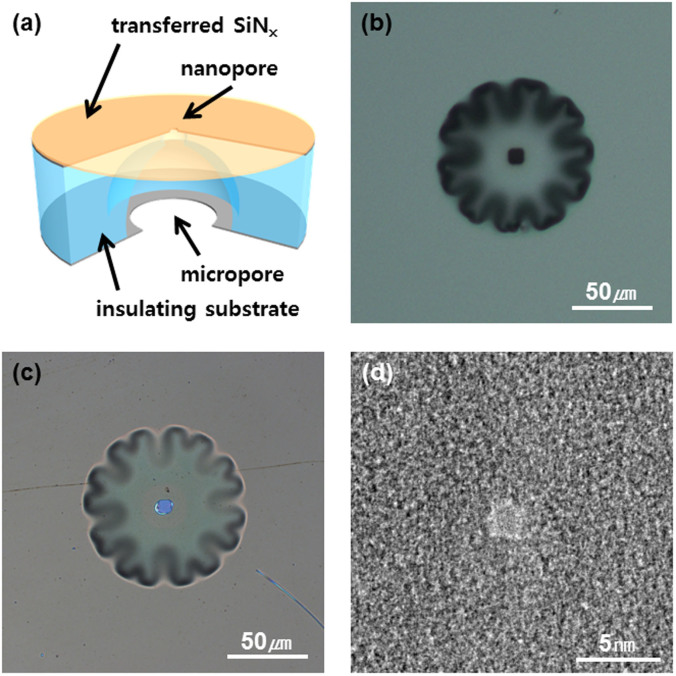
Quartz-substrate-based nanopore.(a), A schematic diagram of a quartz-substrate-based nanopore device consisting of a micrometer-sized pore in a quartz substrate and few nm-thick free-standing SiNx membrane. The SiNx membrane was transferred to the quartz substrate using the “fishing method”. Optical microscope image of micrometer size pore formed in quartz (b), before membrane transfer and (c), after the SiNx membrane transfer. (d), TEM image of a 1.5-nm-diameter nanopore drilled by a highly focused electron beam in TEM.